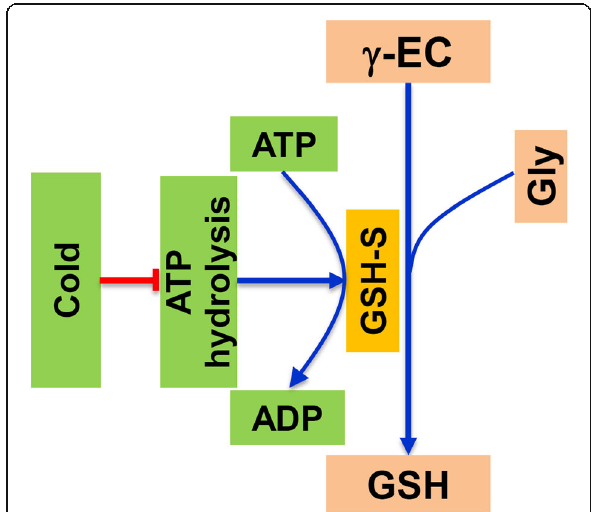
Fig. 7 Descriptive model of the mechanism of cold stress reducing GSH by inhibiting ATP hydrolysis in rice leaves. The γ -EC and Gly is converted into GSH by Glutathione synthetase (GSH-S) in plants. This pathway requires energy consumption (ATP). Under cold stress, ATP content significantly increases in the cold susceptible cultivar, indicating that it is not inhibited by stress. In contrast, cold stress inhibits the hydrolysis of ATP, resulting in low GSH accumulation, thereby reducing available energy. γ -EC, γ -glutamylcysteine; Gly,